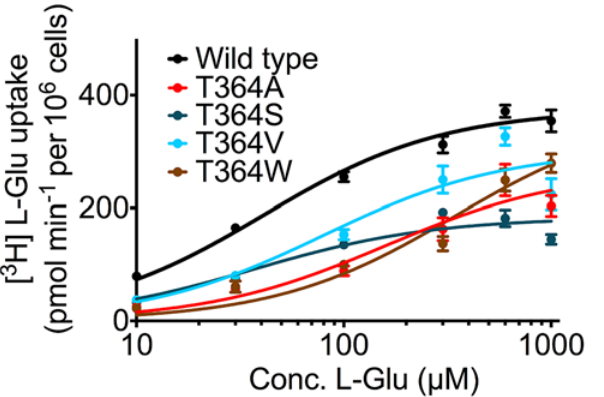
Fig 7. Substrate uptake by human EAAT3. Uptake of [ 3 H] L-glutamate into HEK293 cells expressing the human EAAT3 transporter that carrying the same mutations (A, S, V, and W) at the corresponding residue T364. The data are from three independent experiments; error bars show